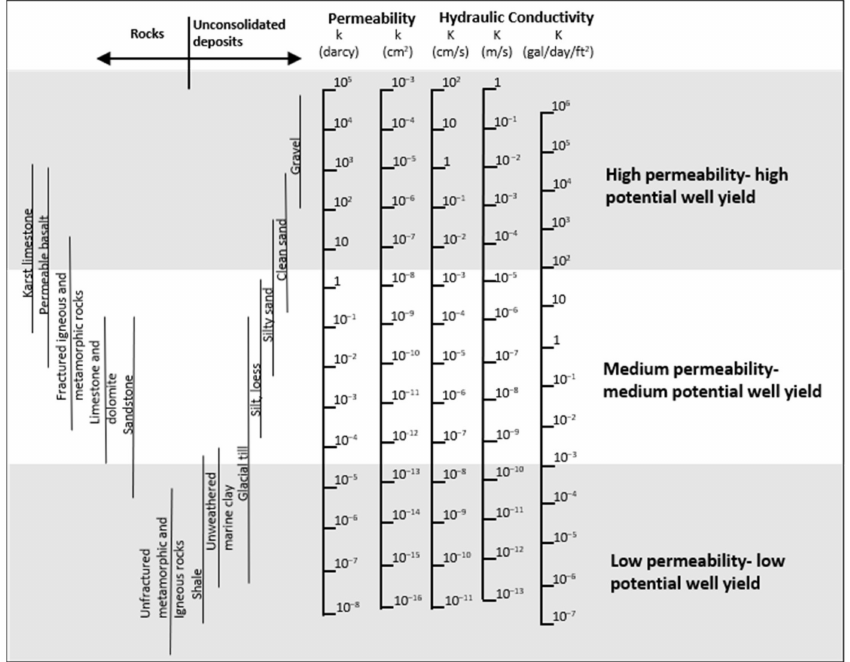
Figure 3. Permeability and hydraulic conductivity of rock units and unconsolidated deposits. Modi- fied from Freeze and Cherry (1979)